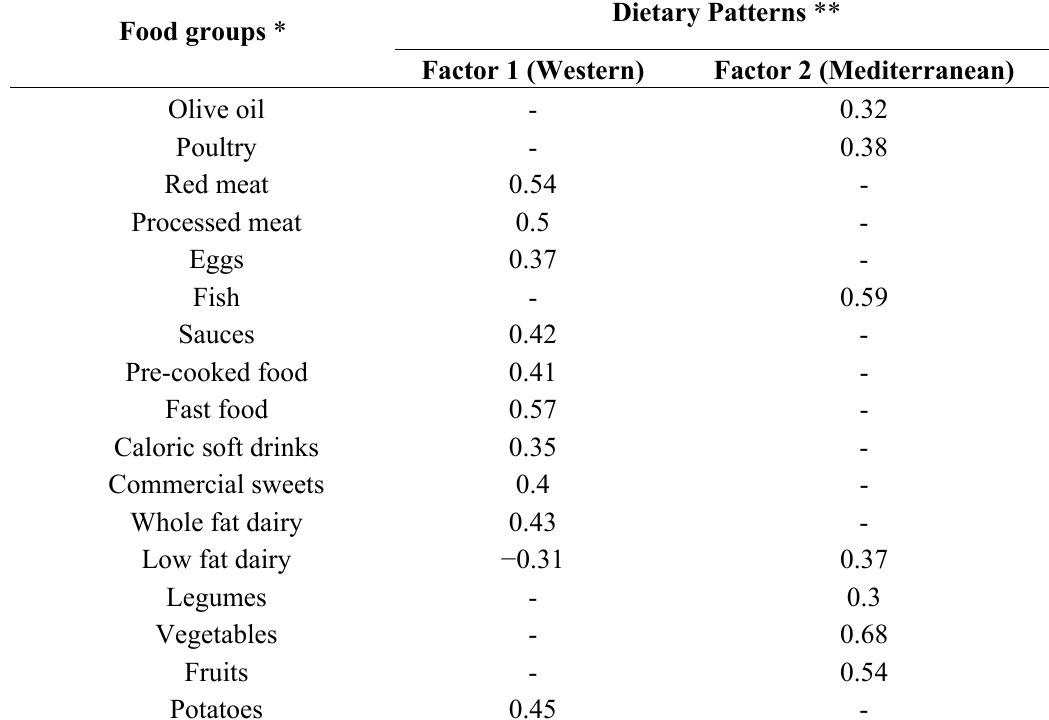
Table 1. Correlation between baseline food consumption and factors representing the Mediterranean and Western dietary patterns in the Seguimiento de la Universidad de Navarra (SUN) cohort study ( n = 17,197)